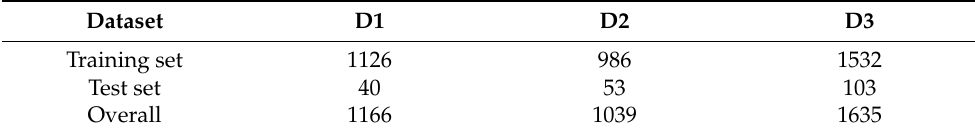
Table 2. Reference dataset.